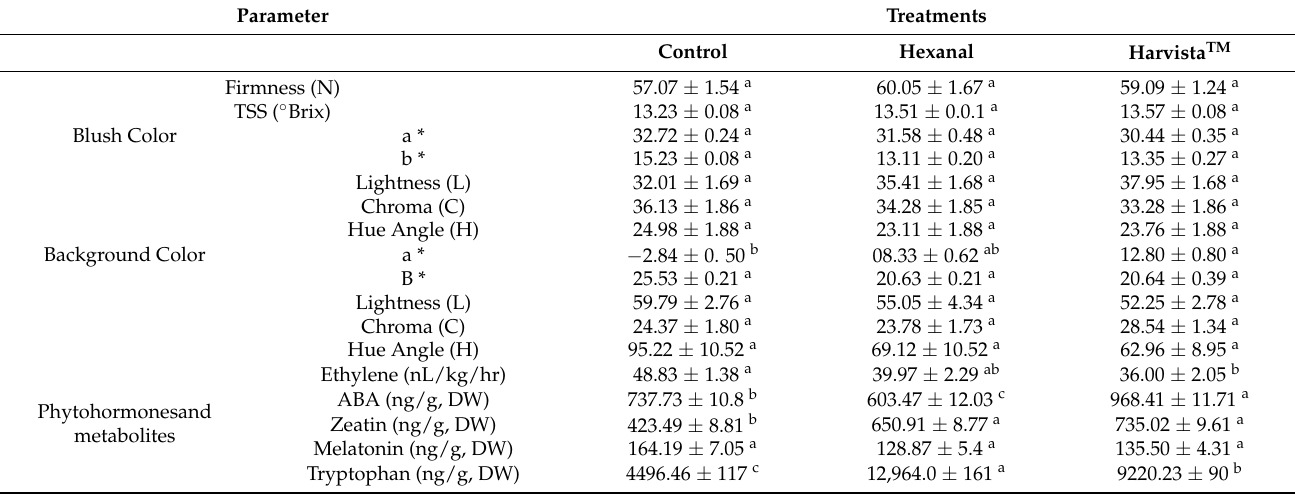
Each value of parameters such as color, firmness, total soluble solids (TSS) and ethylene represents the mean ± SE of eight fruit. Each value of phytohormones represents the mean ± SE of nine replicates (three fruit each with three technical replicates). Means with the different letters indicate significant differences among control, hexanal and Harvista TM treatments based on the Tukey-Kramer test at α = 0.05 at